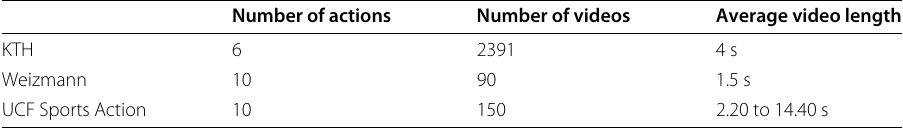
Table 3 KTH, Weizmann, and UCF Sports Action datasets’ description Number of